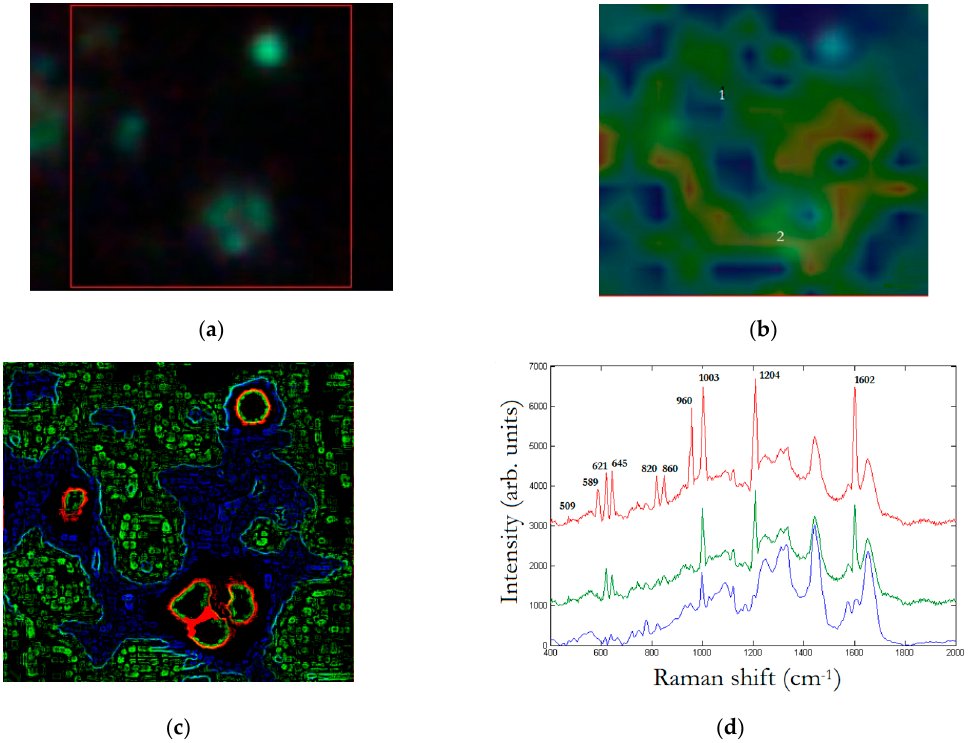
Figure 7. The labels ( a ), ( b ), and ( c ) as in Figure 3, in a nuclear area (5 μ m × 5 μ m) of a MG-63 cell, in Figure 3c red region denotes Γ 2 ~10 5 . ( d ) Represents the correspondent spectra in 1 (blue line), 2 (green line), and in 2 after SERS map (red line).